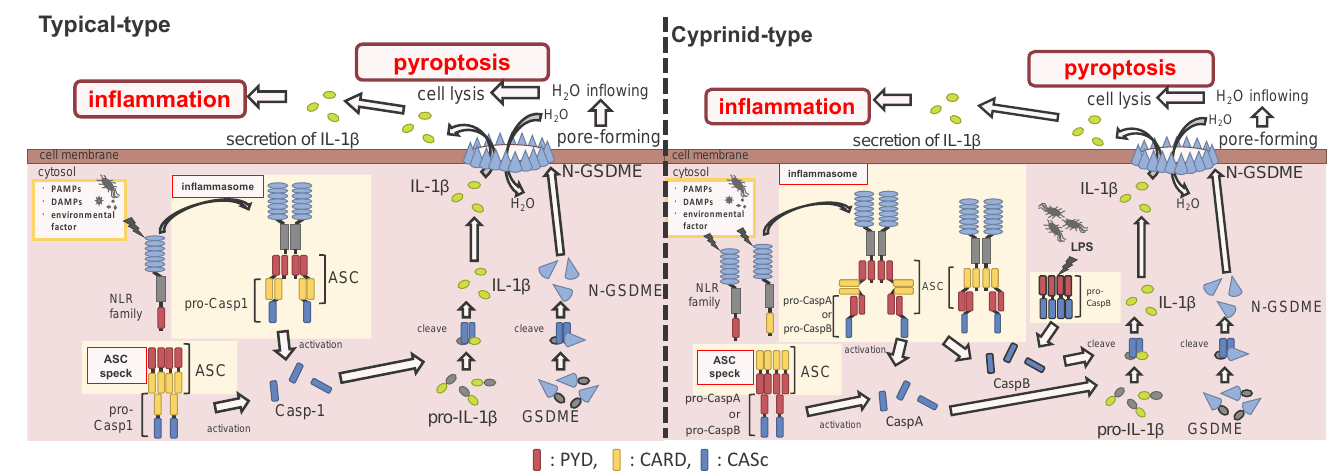
Figure 2. Differences between the cyprinids and other fish species in their inflammasome activation and pyroptosis pathways. In the most fish, the nucleotide-binding oligomerization domain-leucine-rich repeat-containing receptor (NLR) family recognizes the ligands, and bind to apoptosis-associated speck-like protein containing a caspase recruitment domain (ASC) and pro-Caspase1 (Casp1) via pyrin domain (PYD)-PYD and caspase recruitment domain (CARD)-CARD interactions, thus forming the inflammasome. However, in cyprinids, ligands recognize the NLR family and construct two types of inflammasomes: in the first, the NLR family binds to ASC and pro-CaspA/B via CARD–CARD and PYD–PYD interactions, respectively. The NLR family interacts with ASC via the PYD–PYD interaction, and the ASC oligomerization occurs via CARD–CARD (called ASC core). Then, the pro-CaspA/B binds to the ASC core via the PYD–PYD interaction. After activation, the Casp1/A/B undergoes self-proteolysis, and the Casp1 matures interleukin-1β, inducing pyroptosis through gasdermin-E cleavage in all fish, including cyprinids. In addition, the cyprinid’s CaspB works as a non-canonical inflammasome activator, similar to mammalian Casp4/5/11. The pro-CaspB directly recognizes liposaccharides and thus activates by itself.